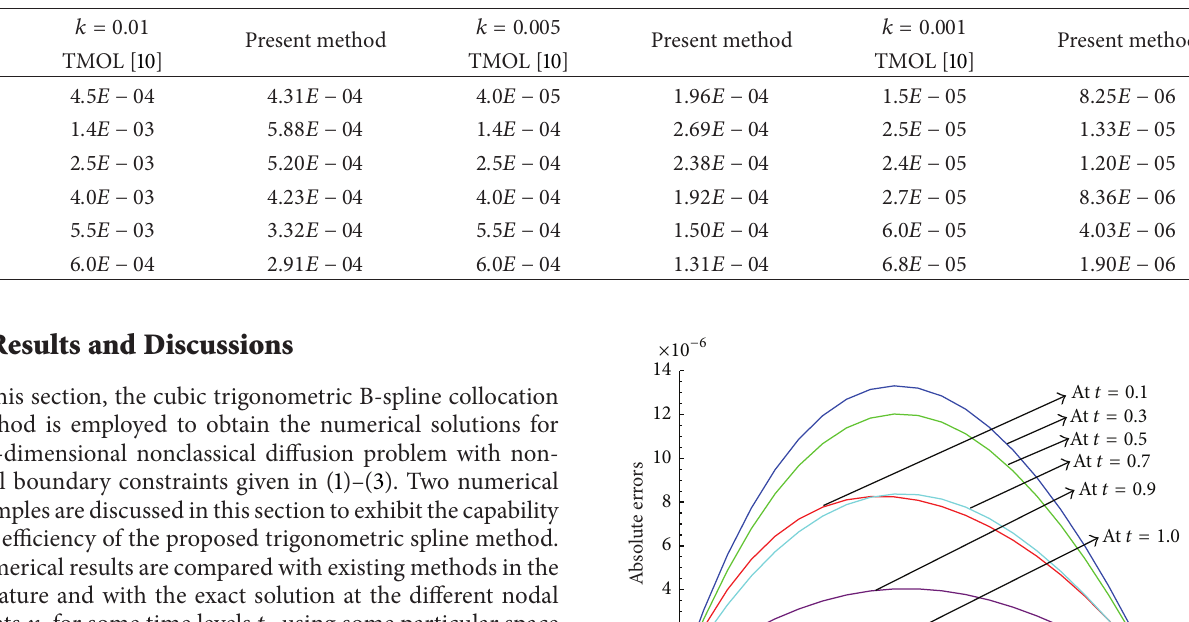
Table 2: Absolute errors for Example 1 with ℎ = 0.05 and several values of time step by present method (CuTBSM) and compare with TMOL [10].